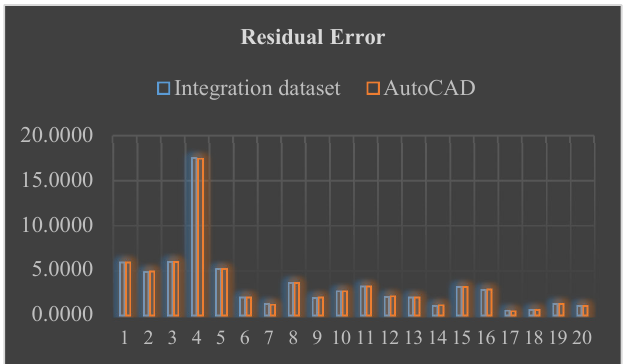
Figure 16. The graph of residual error of both